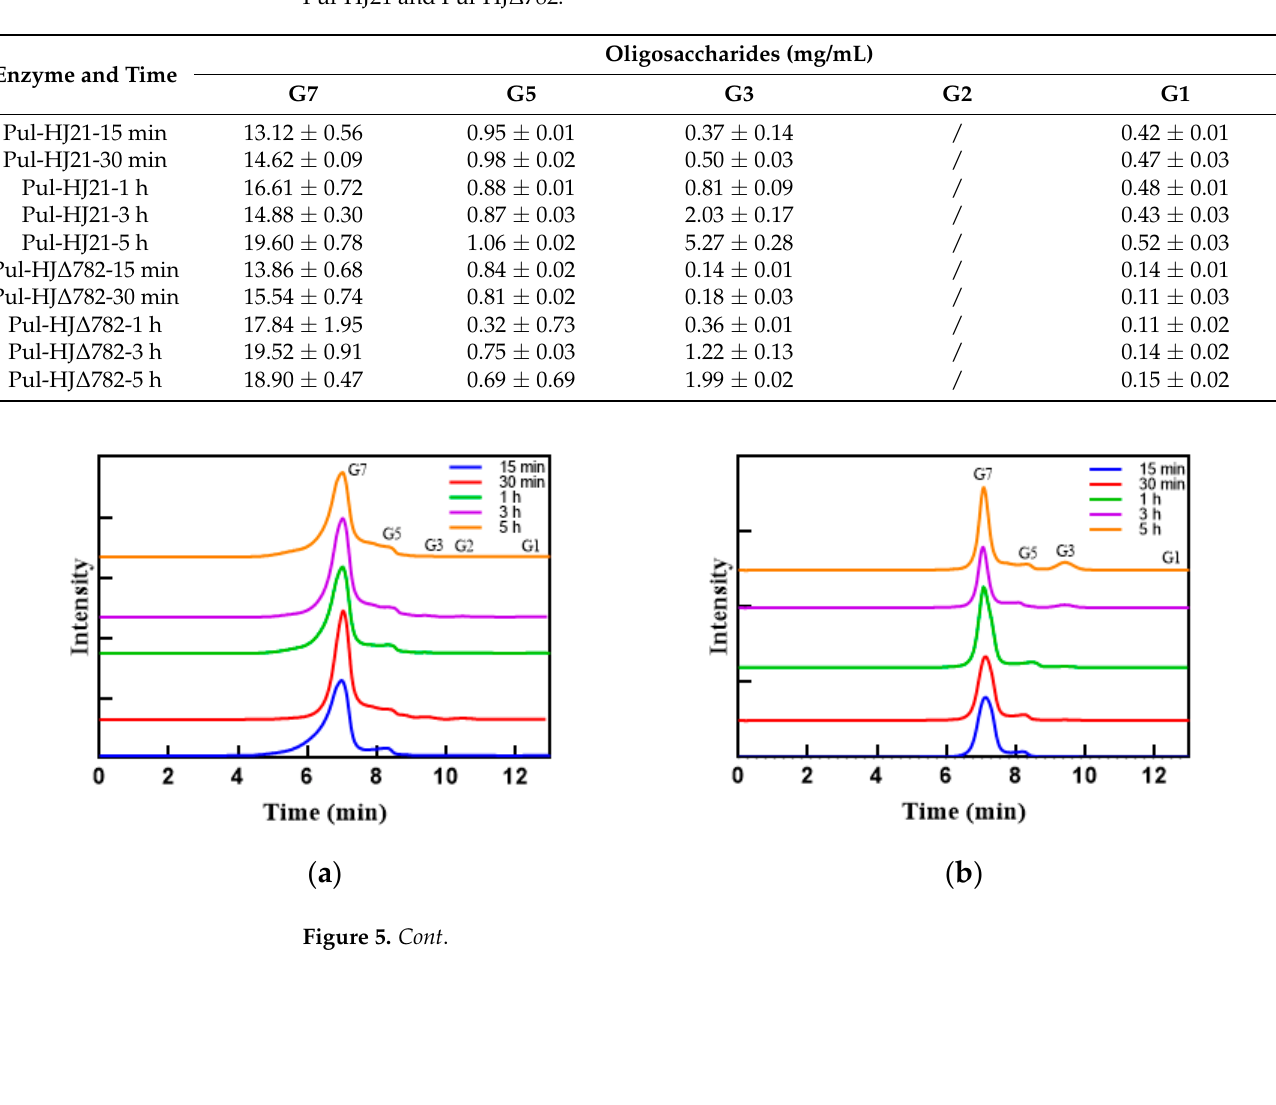
Table 4. Concentration of hydrolysates after the enzymatic digestion of pullulan at different times by Pul-HJ21 and Pul-HJ Δ 782.